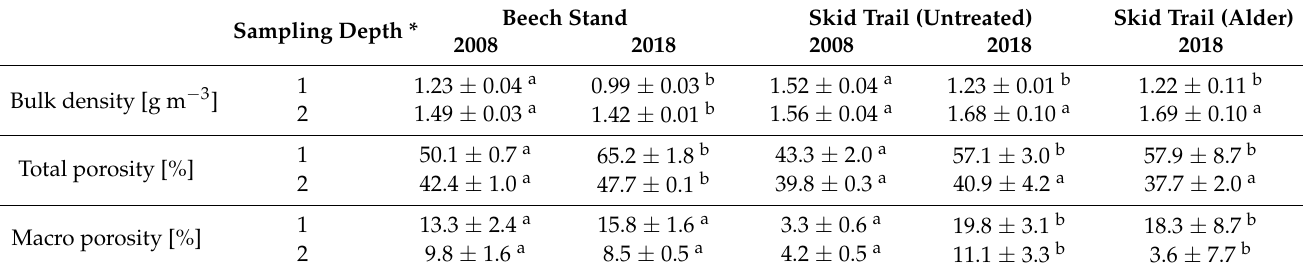
Table 1. Median values of bulk density, total porosity and macro porosity and their 95% confidence interval in the undisturbed beech stand (control) and on the wheel track of the untreated skid trail and the skid trail planted with black alders. Different letters indicate significant median differences (Dunn’s test) between 2008 and 2018.